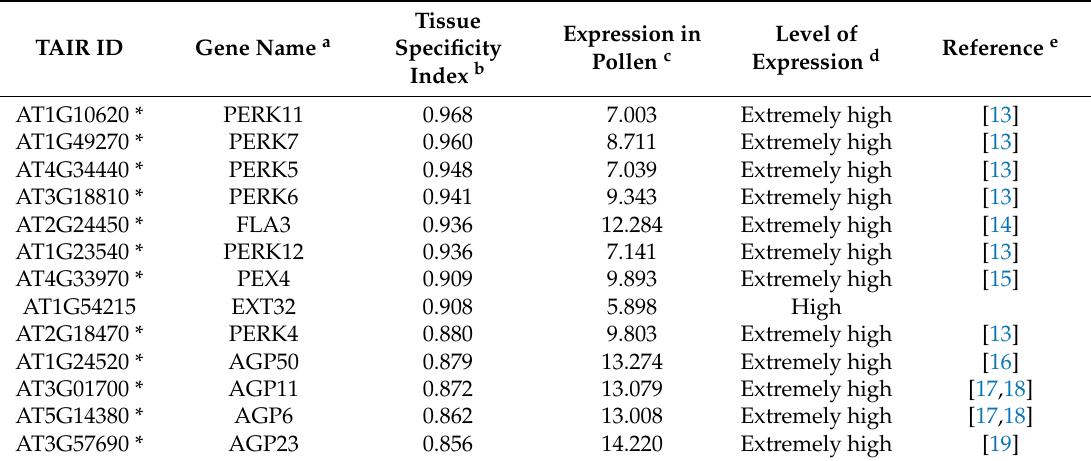
Table 1. List of pollen-specific HRGP